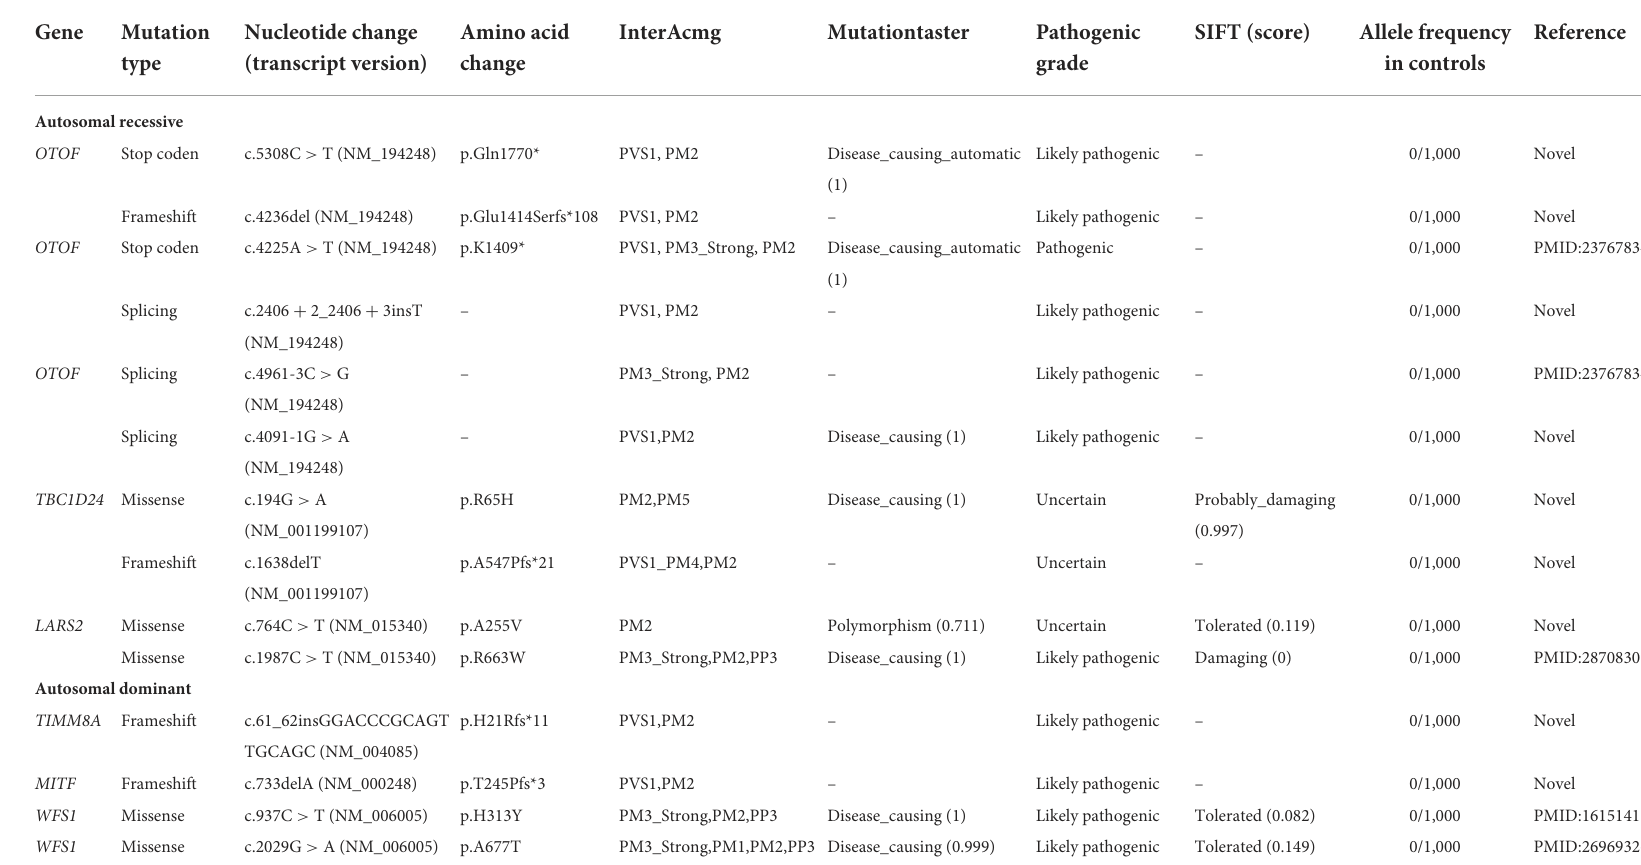
TABLE 1 The gene mutations of the 9 families.